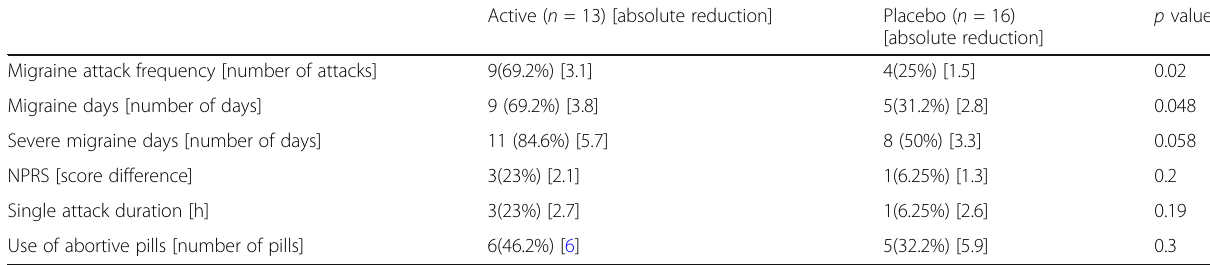
Table 3 Comparison between the two treatment groups regarding the number of cases achieving a minimum of 50% reduction, and the absolute reduction in different migraine severity